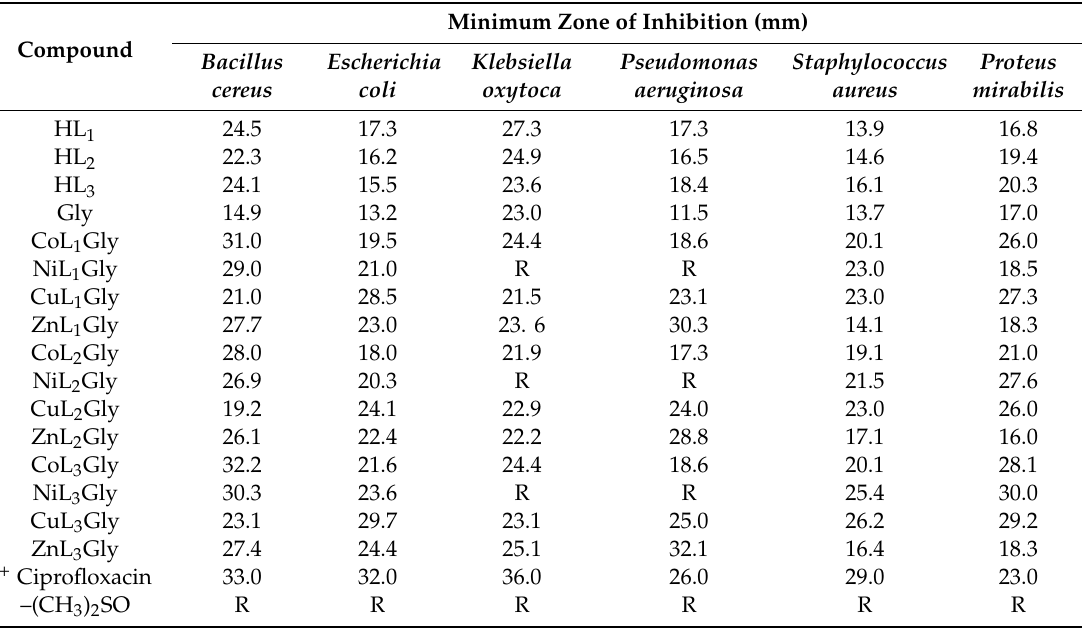
Table 3. Antibacterial data of HL 1–3 , Gly and their heteroleptic complexes at 1 mg / mL